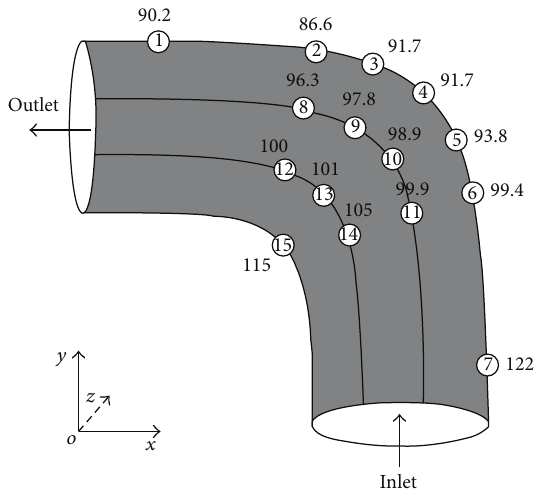
Figure 3: Distribution of corrosion current densities of array electrodes at test section under fluid flow condition with the flow velocity of 5.31 m/s (unit: 𝜇 A/cm 2 ).